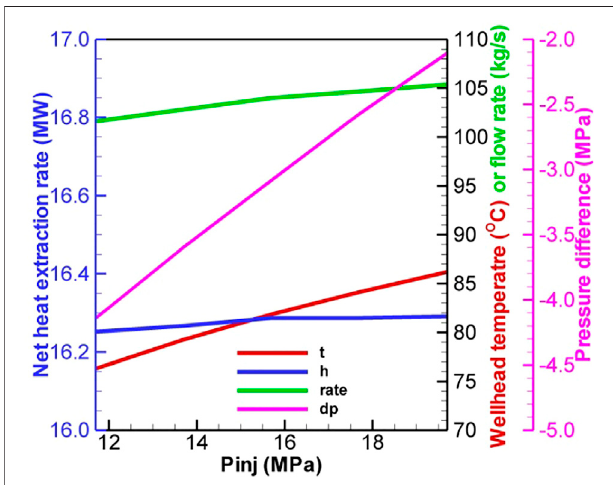
FIGURE 14 | Effect of injection pressure on performance with the temperature drop limitation for the CO 2 -based EGS.